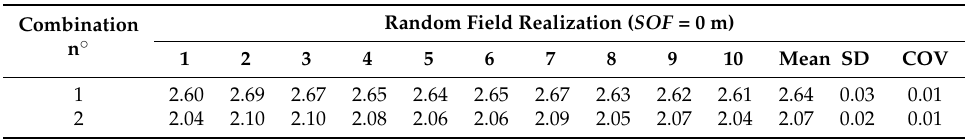
Table 18. Factors of safety results for spatially varied strength parameters with scale of fluctuation of 10 m. Random Field Realization ( SOF = 10 m) Combination n°